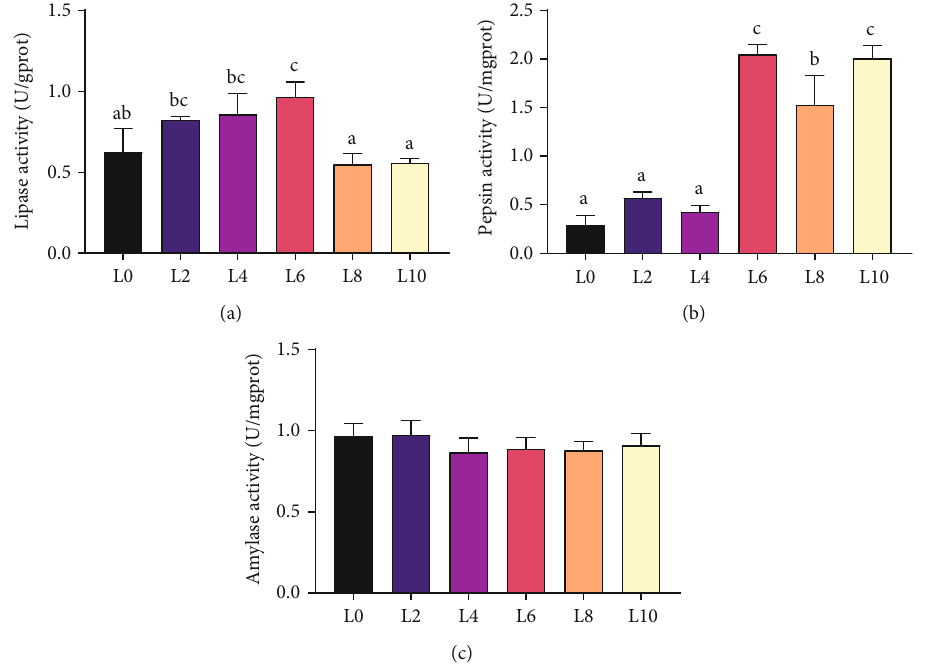
Figure 4: The activities of lipase (a), pepsin (b), and amylase (c) in the gut of C. quadricarinatus fed diets with di ff erent lipid levels. All data are expressed as the mean ± SE ( n = 6 ). Di ff erent letters indicate signi fi cant di ff erences among experimental groups ( P < 0 : 05 C15:0, C16:0, and C22:6n-3 in muscle were signi fi cantly positively correlated with C17:0 in diets ( P < 0 : 05 ). Fur- thermore, most of the fatty acids in muscle were not closely related to the dietary fatty acid composition.